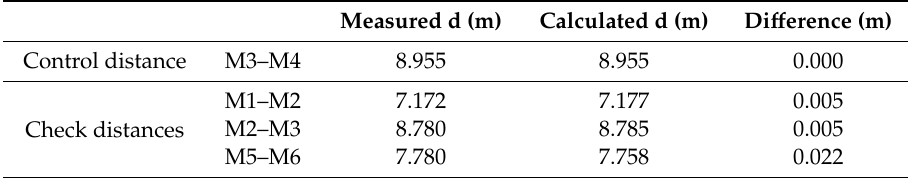
Table 2. Differences between measured distances and calculated distances from photogrammetric model. Table2. Di ff